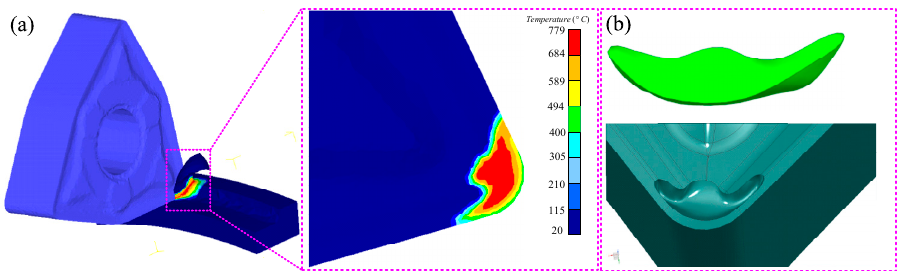
Figure 1. Simulation model of cutting and temperature distribution of cutting tool tip. ( a ) Cutting simulation model. ( b ) Micro groove formation process. simulation model. ( b ) Micro groove formation